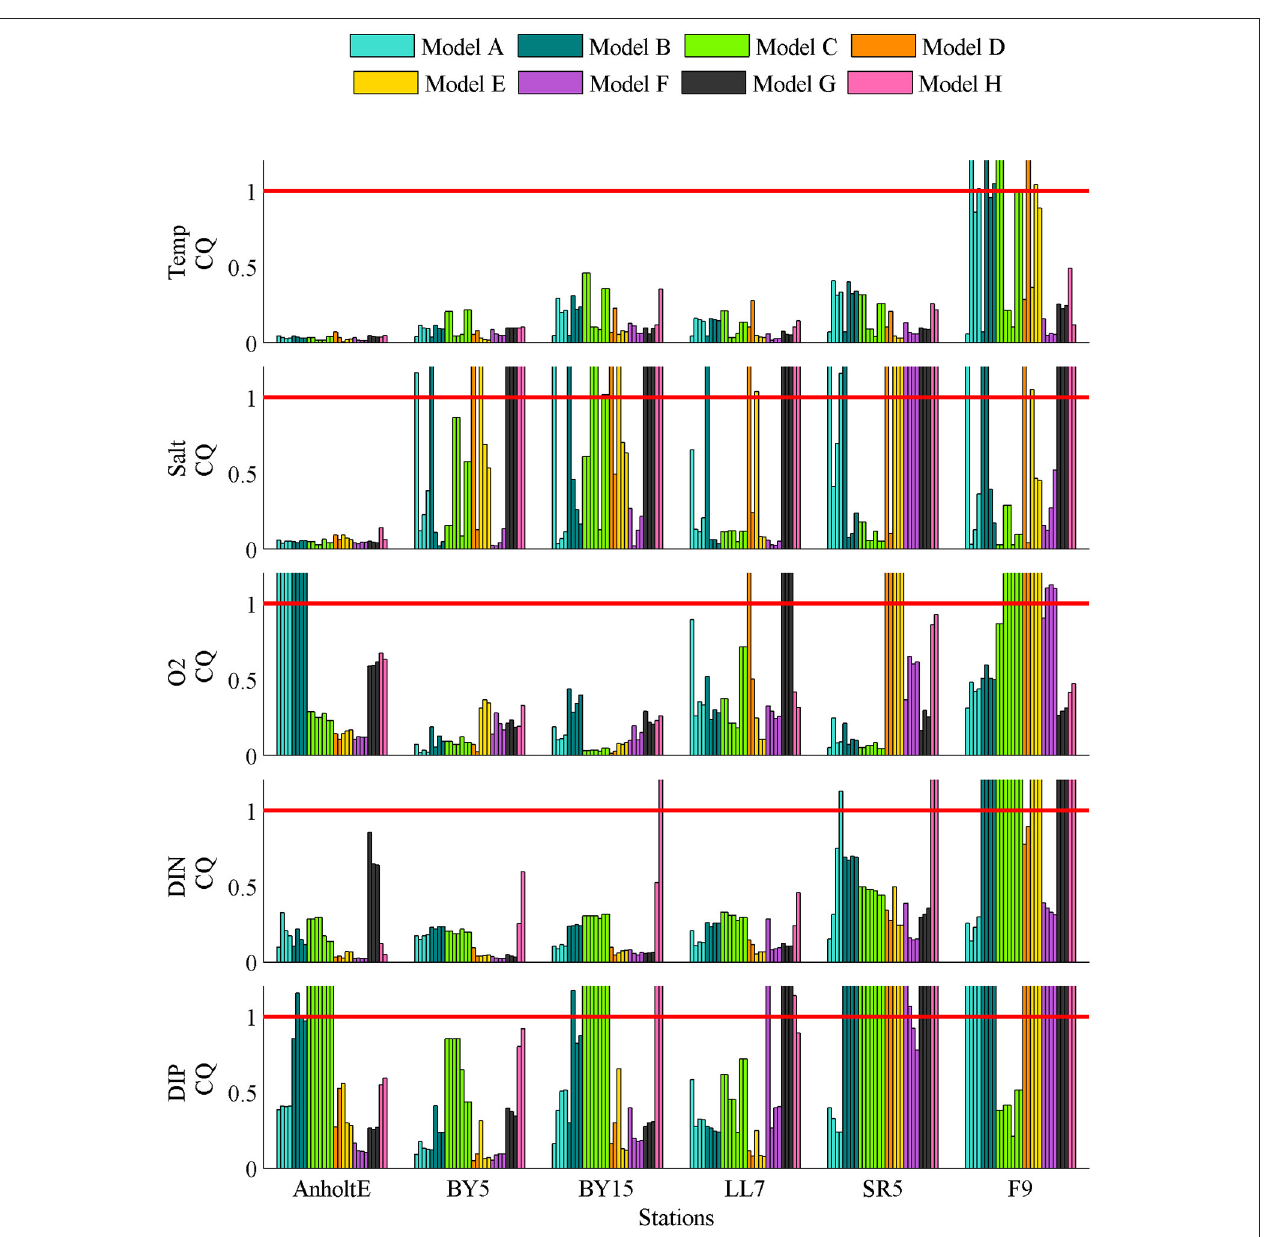
FIGURE 5 | Normalized cost function (Equation 4) for temperature, salinity, oxygen, DIN and DIP concentrations at the monitoring stations Anholt East (AE), Bornholm Deep (BY5), Gotland Deep (BY15), Gulf of Finland (LL07), Bothnian Sea (SR5), and Bothnian Bay (F9) for all scenario simulations of Model A to H during the historical period 1980–2005. Only simulations with a cost function value, CQ , smaller than one (red line) for all stations and all variables are considered for the weighted